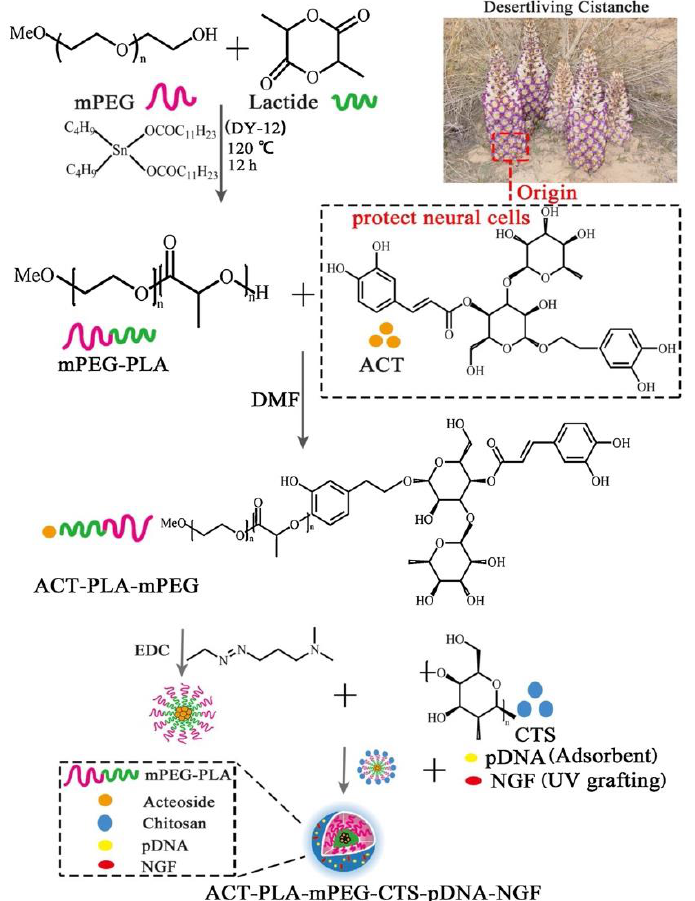
Figure 7. Schematic illustration of the prepared nanoparticles based on chitosan poly ethyleneglycol-poly lactic acid (PEG-PLA) nanoparticles coupled with NGF, acteoside, and pDNA. Reprinted from the Journal of Material Science and Technology, 43, Xue et al. Neuroprotective effect of chitosan nanoparticle gene-delivery system grafted with acteoside (ACT) in Parkinson’s disease models, 11, copyright (2020), with permission from Elsevier [107].